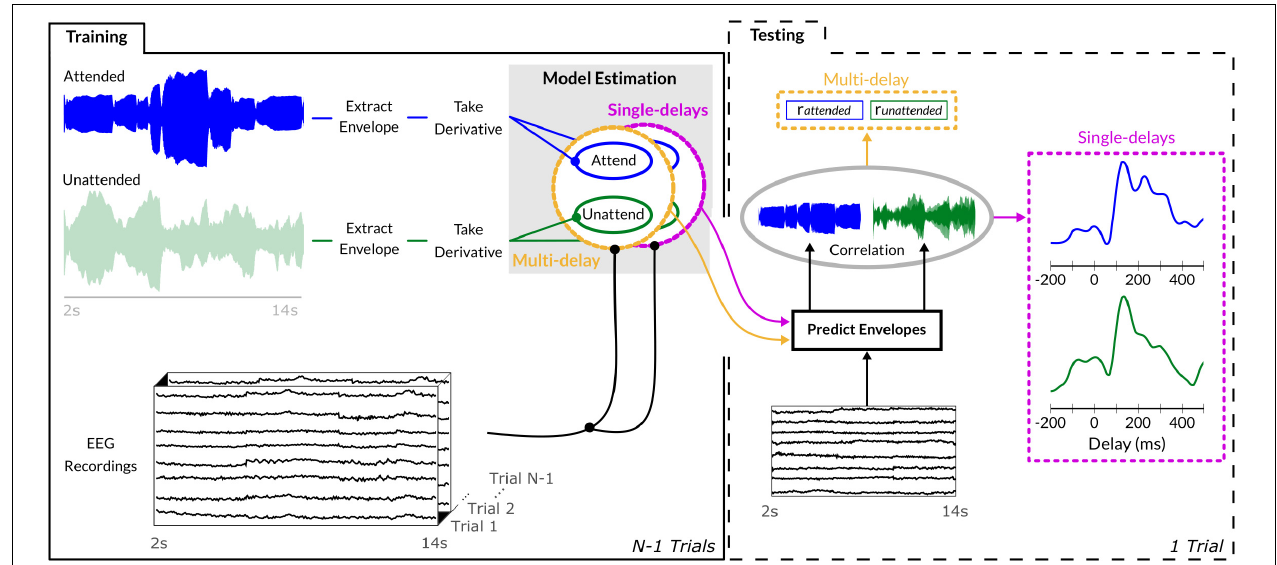
FIGURE 2 | Sound envelope tracking method. Envelopes were extracted from each instrument’s waveform via an absolute Hilbert transform, its derivative was employed to estimate both single-delay and multi-delay envelope models on N -1 training trials. To assess generalization, the estimated envelope model was used to predict the sound envelope of the single unseen trial and its output correlated with the trial’s actual sound envelope. Multi-delay models provided output in a single correlation value encompassing the evidence of all delays between 0 and 400 ms, while the single-delay models generated a correlation value for each individual delay between –200 and 500 ms (10-ms step